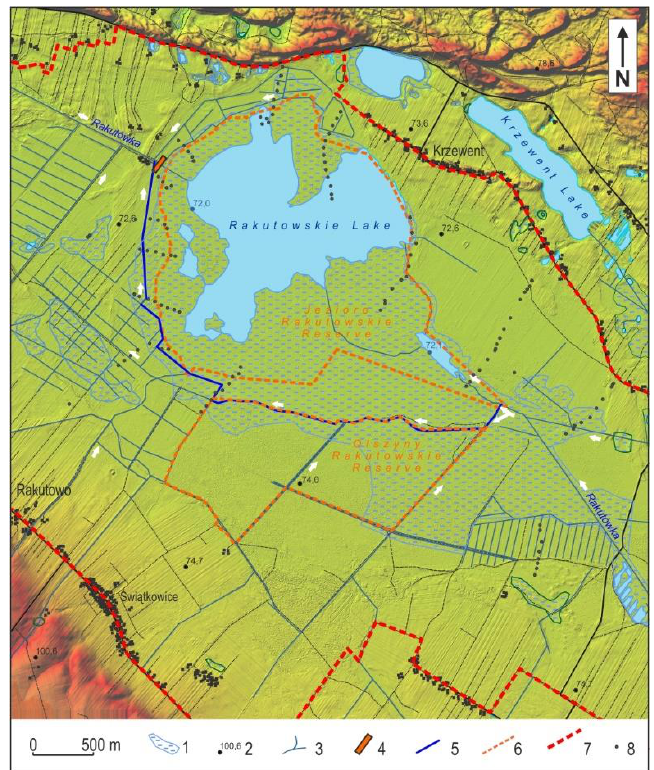
Figure 2. Surrounding of Rakutowskie Lake, 1. Wetlands, 2. Elevation points, 3. Drainage system, 4. Penstock, 5. Drainage ditch, 6. Nature reserve borders, 7. Nature 2000 borders, 8. Drilling locations.